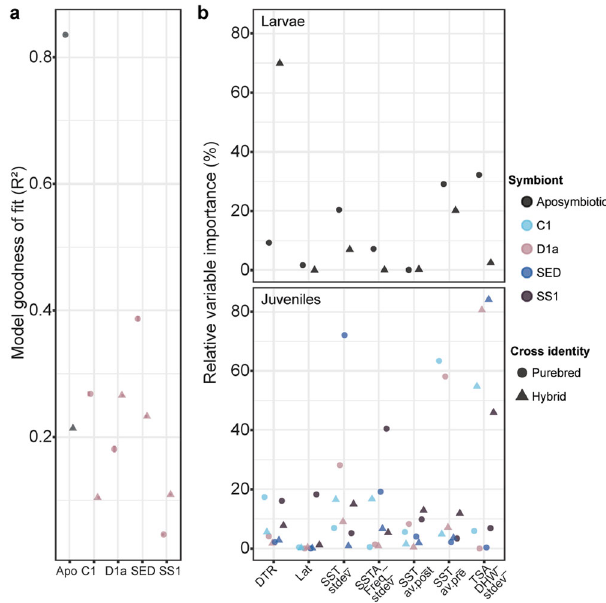
Fig. 3 Assessment of Gradient Boosted Model (GBM) performance across all coral and symbiont combinations. The abbreviations follow- Apo: Aposymbiotic, C1: Cladocopium goreaui , D1a: Durusdinium trenchii , SED: Sediments, SS1: Selected Strain ( a ) ( R 2 = via Boosted Regression Trees).